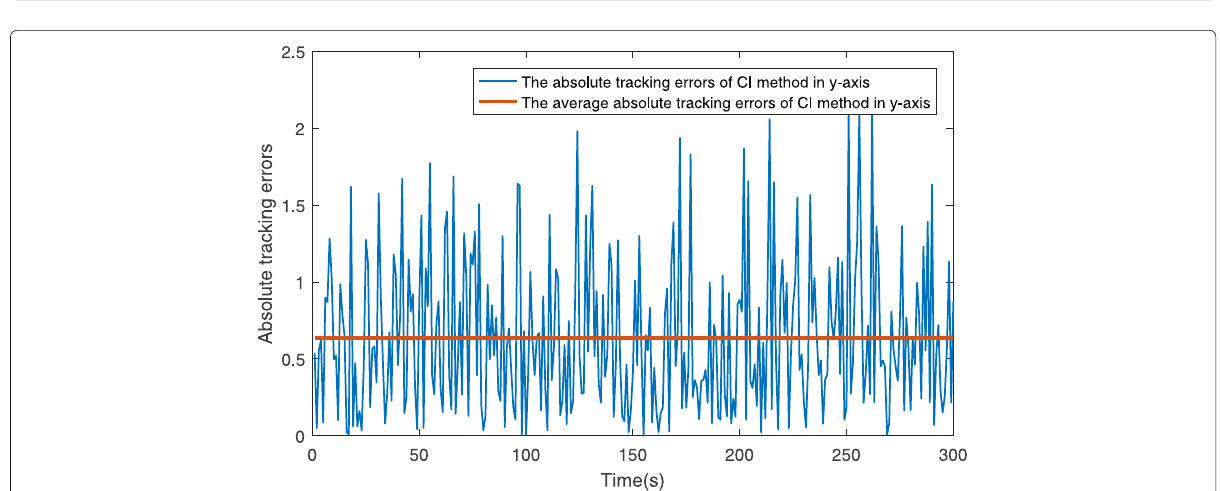
Fig. 20 The absolute tracking errors of CI method in y -axis with varied